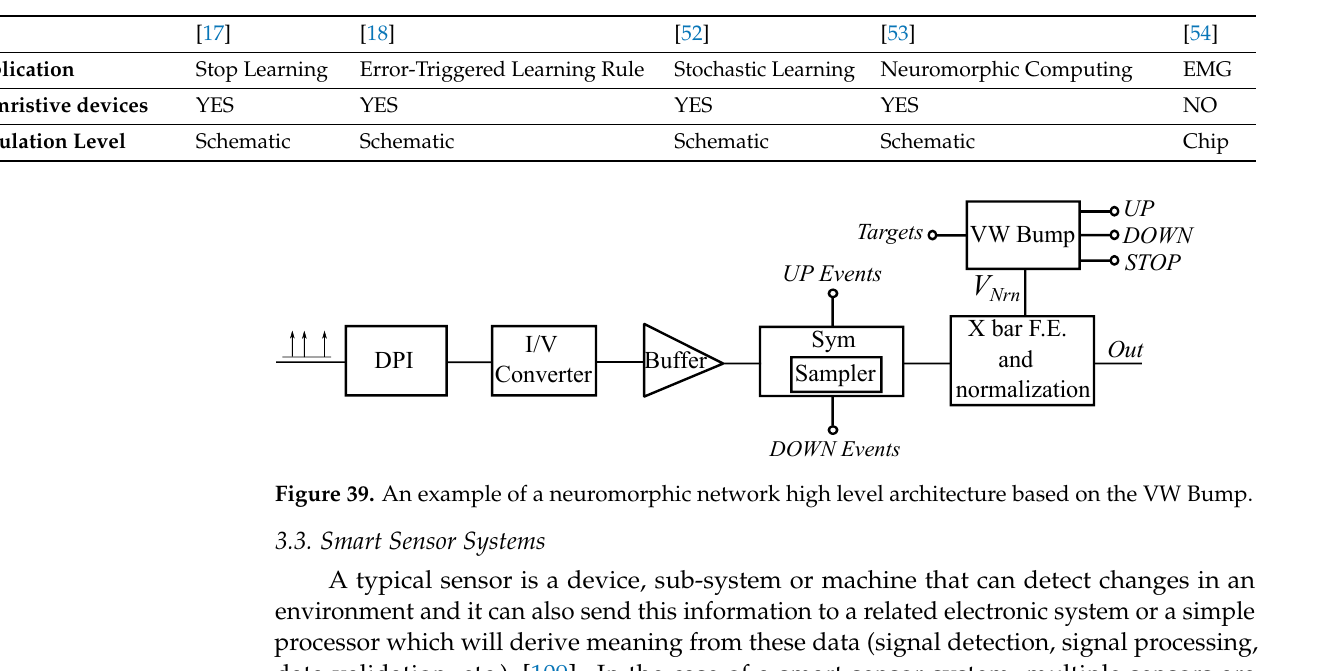
Table 8. Neuromorphic Systems Summary.